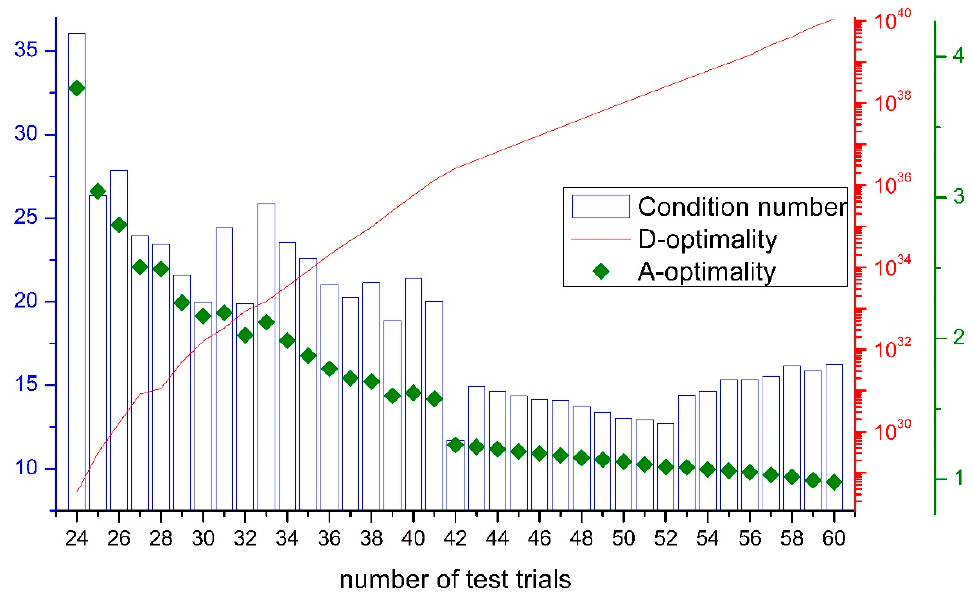
Figure 1. Analysis of the D- and A-optimality as well as the condition number in dependency of the test runs.